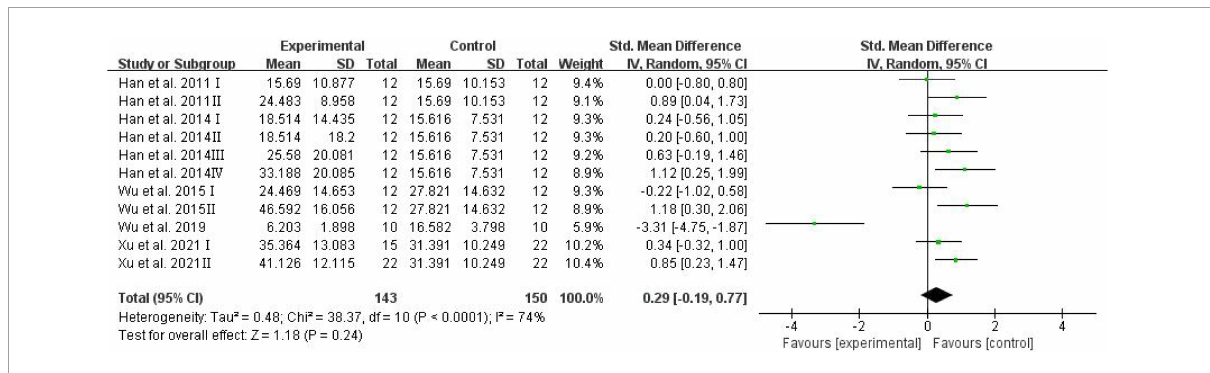
FIGURE5 Forest plot of the escape latency in the Morris water maze test.